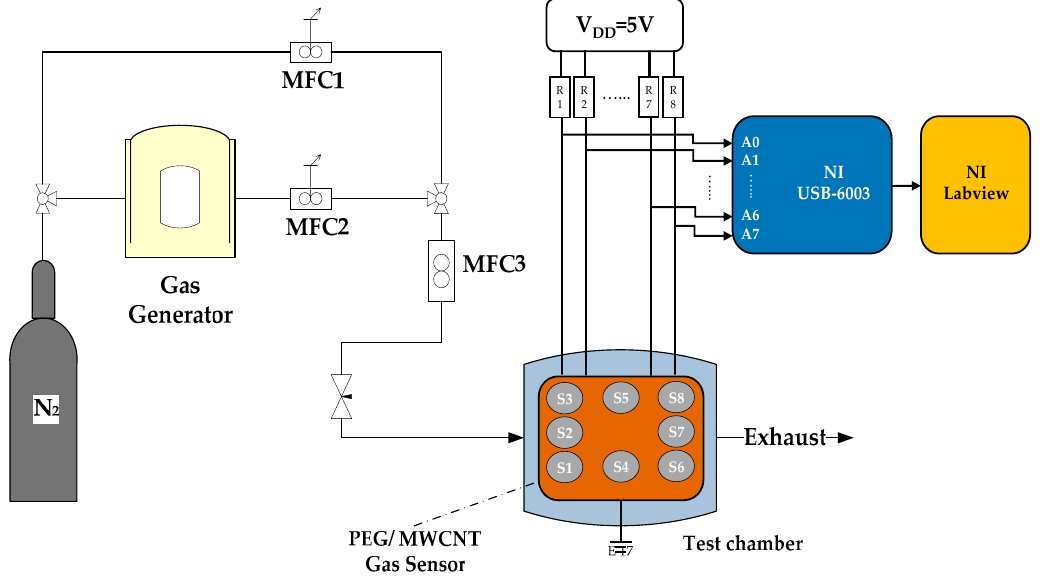
Figure 5. Test instrument of the PEG/MWCNTs gas sensor .